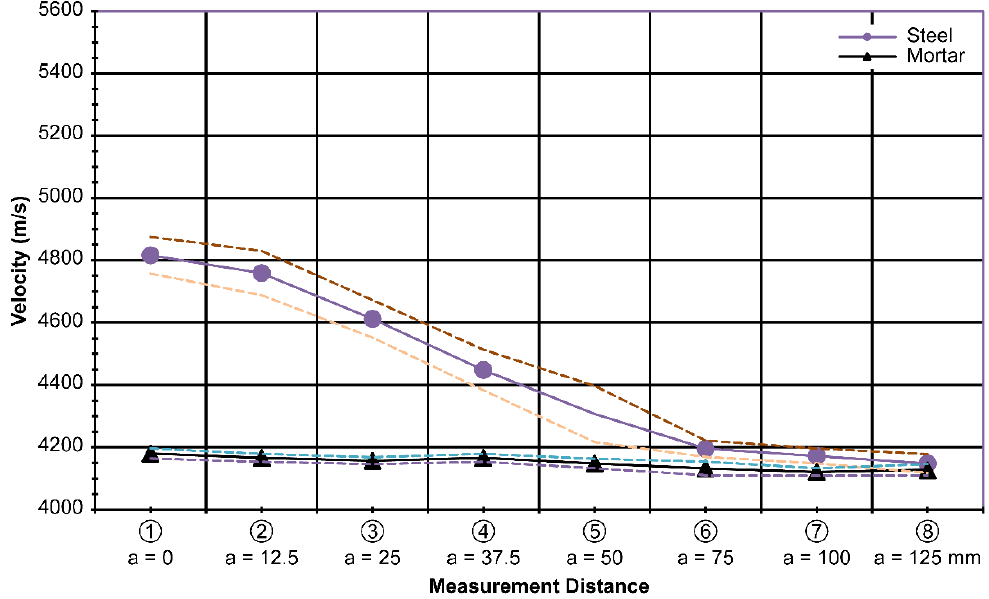
Figure 8. Combined measurement data with steel thickness (t)variation at d =75 mm and h = 150 mm. Figure 8 combines all of the measurement results for varying thicknesses(t). The standard deviation of the measurements with varying thicknesses of the steel plate was 204 m/s.